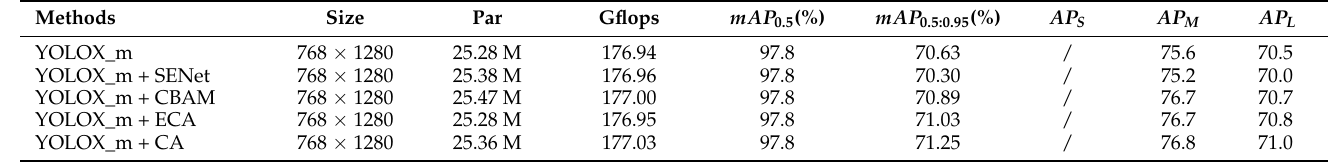
Table 3. Performance comparison of different attention mechanisms.